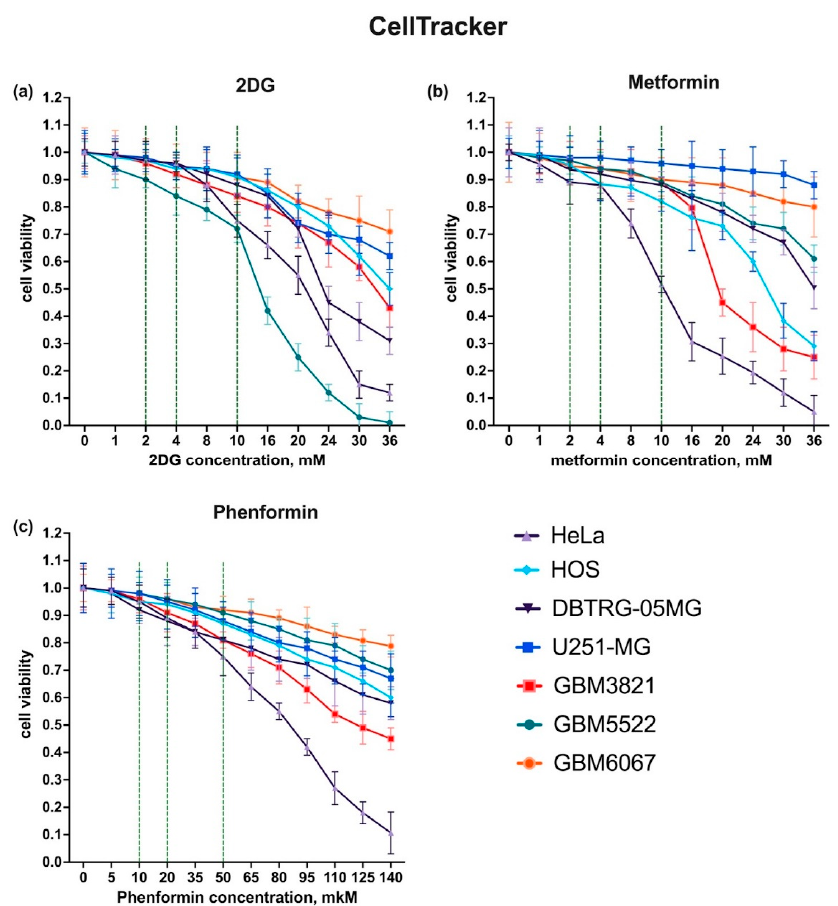
Figure 2. Cytotoxicity of metabolic inhibitors towards glioblastoma cell lines assessed using CellTracker reagent. Cells were seeded 24 h before exposure to increasing concentrations of 2DG ( a ), metformin ( b ), or phenformin ( c ). Cell viability was assessed 48 h after drug addition using CellTracker reagent.